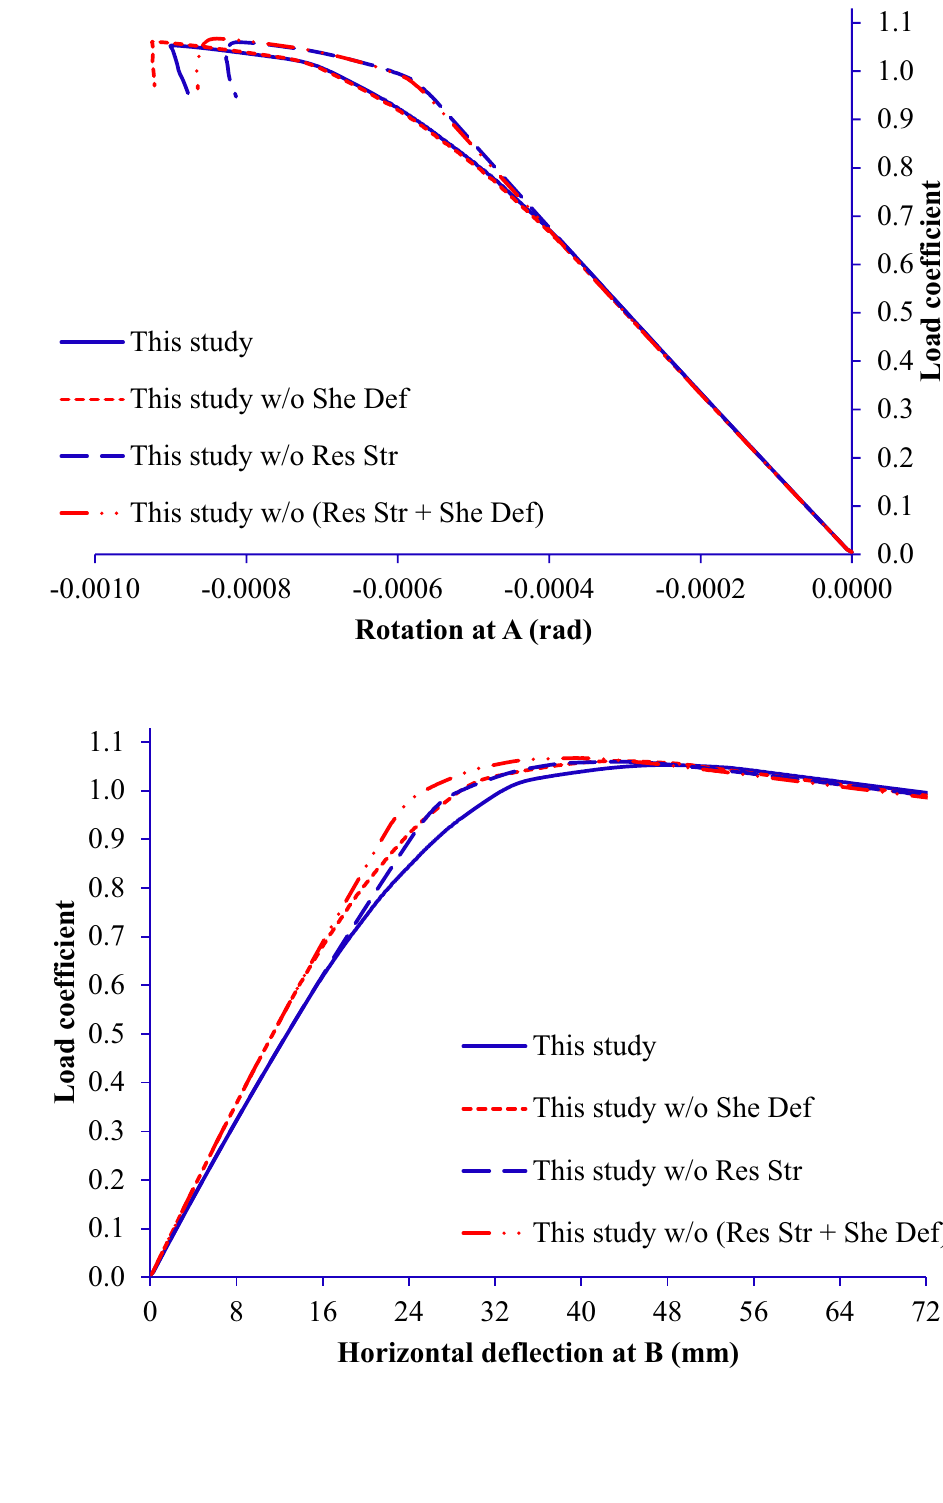
Fig. 28 Load-rotation relation- ship at A of nine-story frame